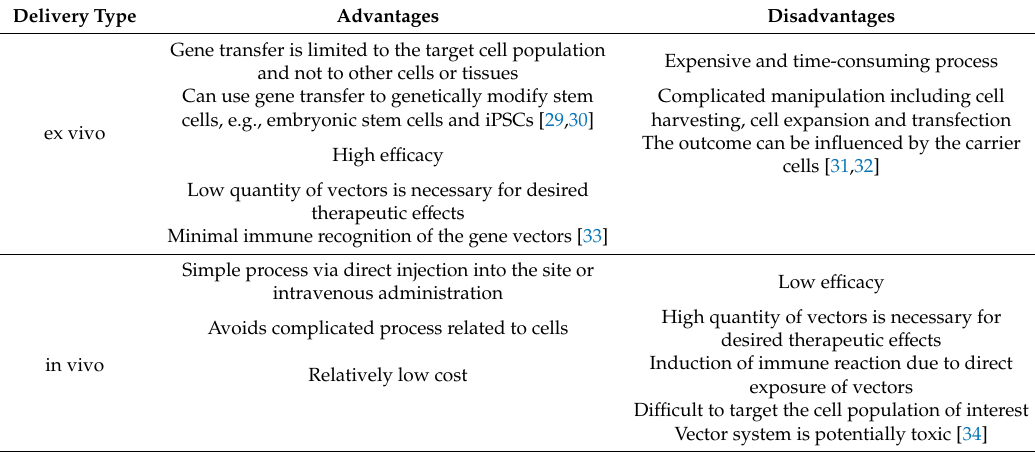
Figure 2. Regeneration strategy for the reconstruction of periodontal tissue through gene therapy. Table 1. Advantages and disadvantages of ex vivo and in vivo BMP-2 gene delivery